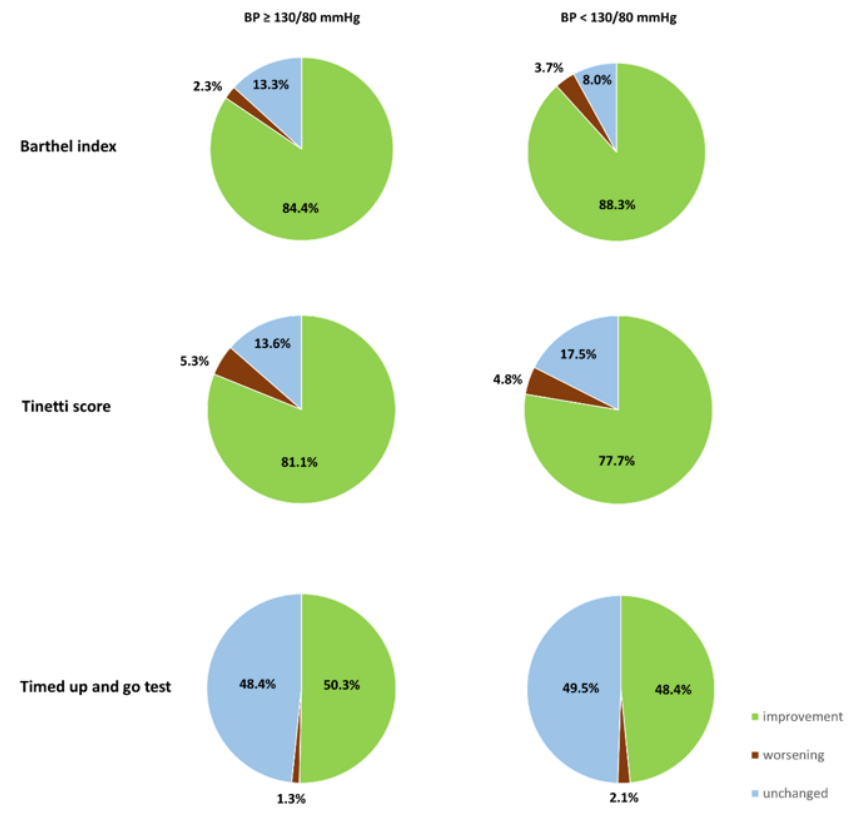
Figure 1. Functional outcomes after comprehensive geriatric care among older adults with and without hypertensive blood pressure (BP)